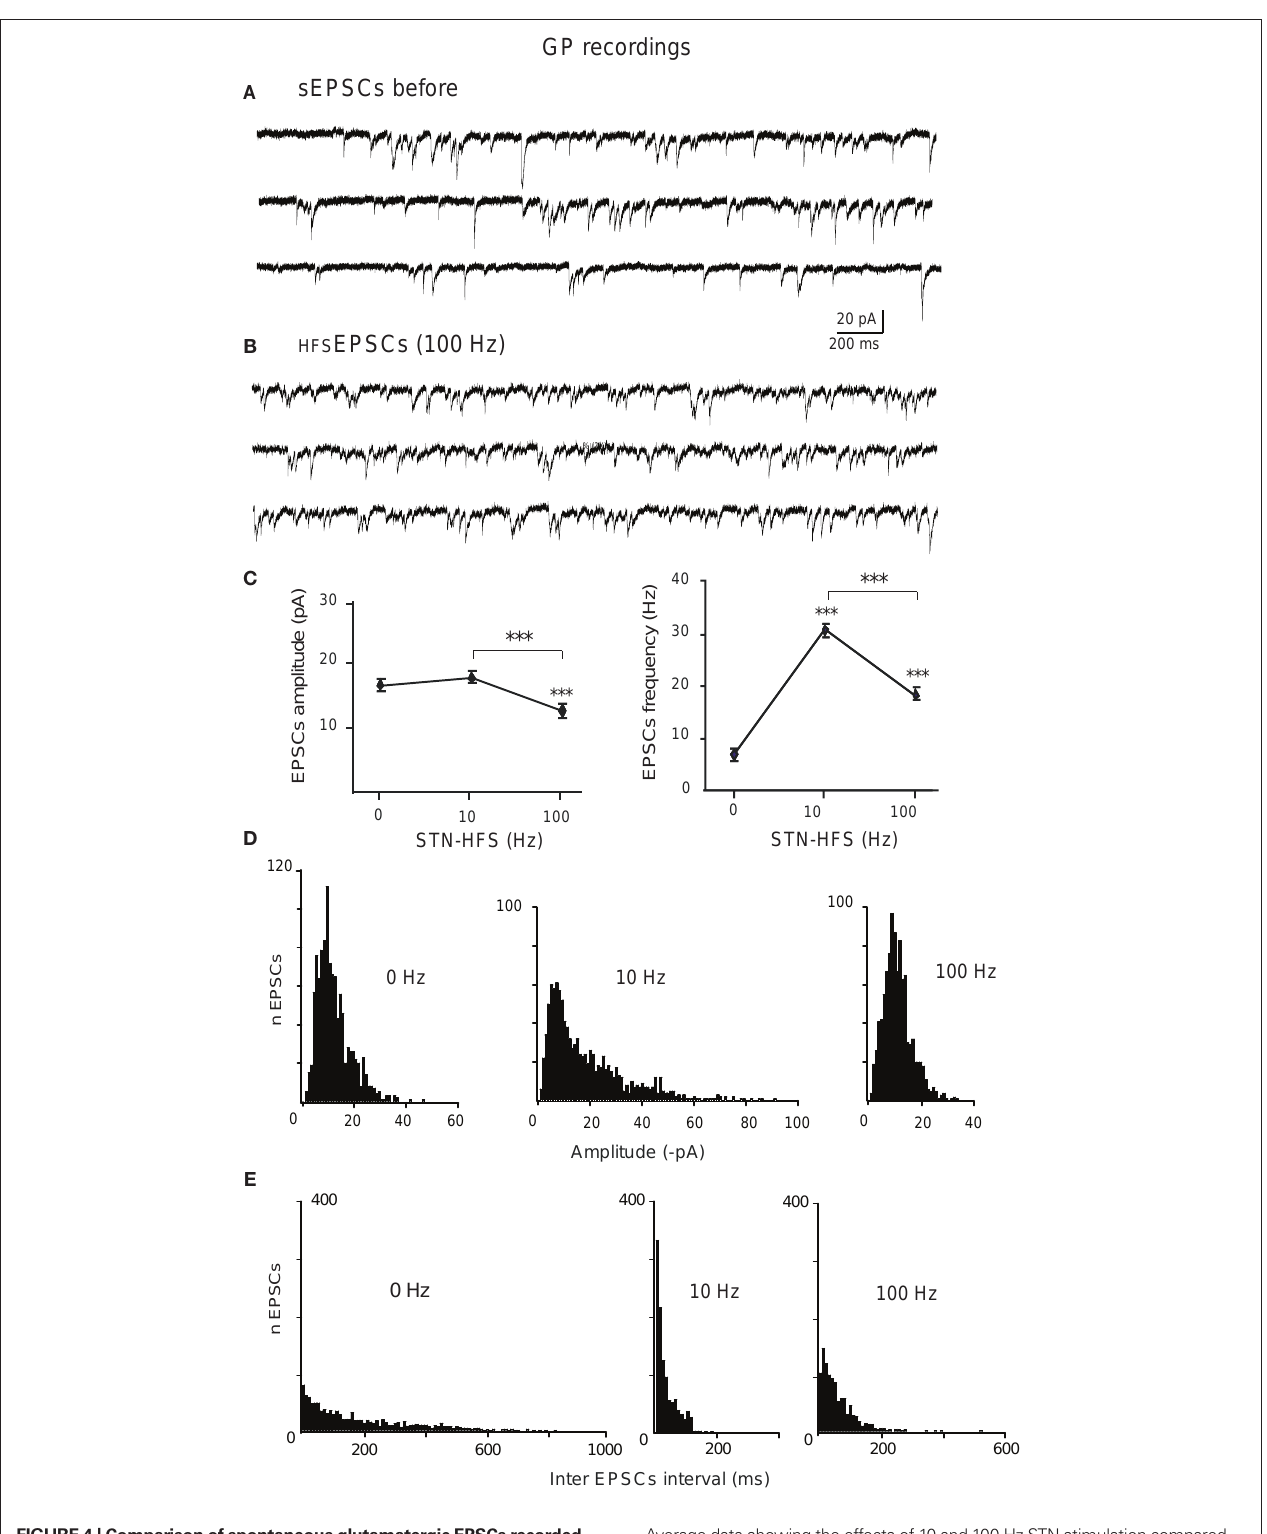
Average data showing the effects of 10 and 100 Hz STN stimulation compared Figure 4 | Comparison of spontaneous glutamatergic ePSCs recorded to before HFS (0 Hz) on the amplitude and frequency of the EPSCs recorded in before and during STN-HFS. (A) Three example traces showing the DA-depleted GP neurons. Each data point is the mean ± SEM. Histograms of the spontaneous EPSCs (sEPSCs) recorded in voltage clamp mode ( V = − 70 mV) H amplitudes [bin 1 pA, (D) ] and inter EPSCs intervals [bin 10 ms, (e) ] for the from a GP neuron in a BGS from a reserpinized mouse. (B) Three example traces spontaneous EPSCs (0 Hz) and the EPSCs recorded during 10 or 100 Hz STN from the same GP neuron as in (A) showing the EPSCs recorded during HFS stimulation in the same GP neuron, as STN-HFS at 100 Hz ( EPSCs, filtered traces without stimulation artifacts). (C) HFS